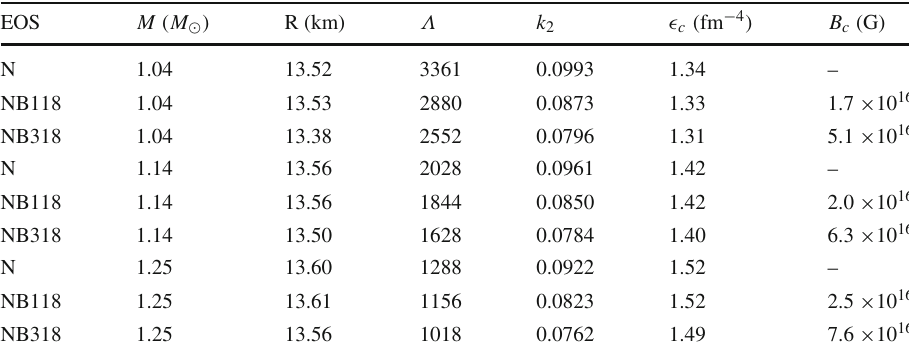
Table 4 Properties of low mass neutron stars for different values of magnetic